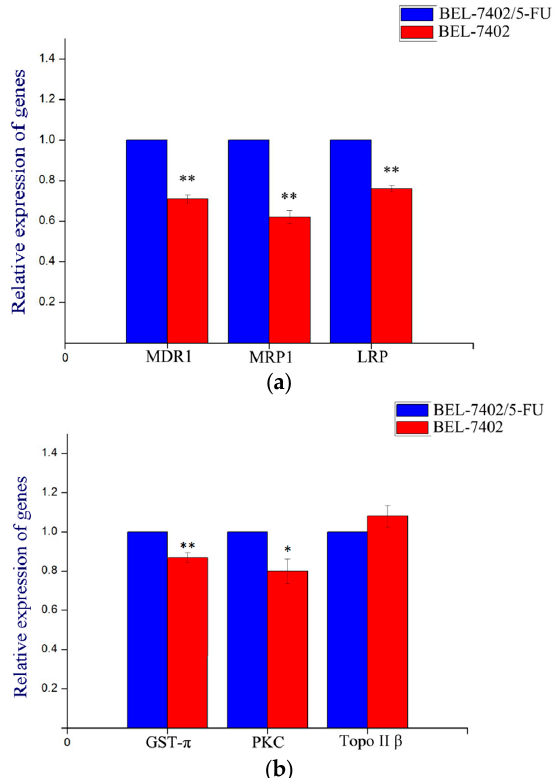
Figure 5. The relative expression of multidrug resistance-associated genes in BEL-7402 cells and BEL-7402/5-FU cells. Values are presented by mean ± SD ( n = 6). ( a ) Gene expression of multidrug resistance-associated proteins; ( b ) gene expression of multidrug resistance-associated enzymes. * p < 0.05, ** p < 0.01 vs. BEL-7402.